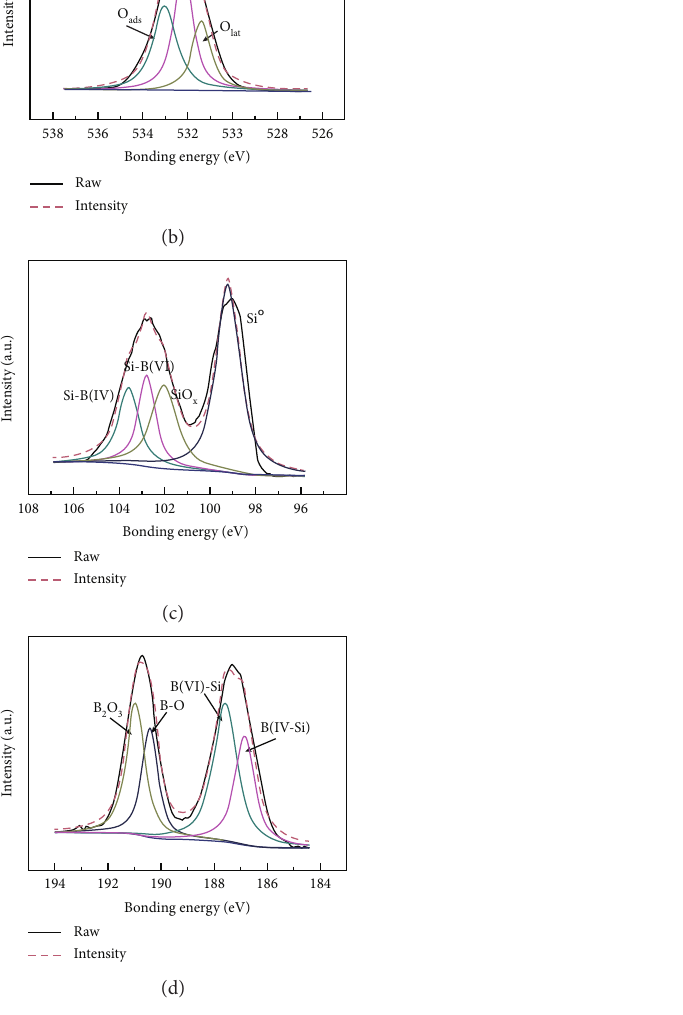
Figure 3: X-ray photoelectron spectroscopy (XPS) spectra of all samples: (a) survey of products; (b) O 1s; (c) Si 2p; (d) B